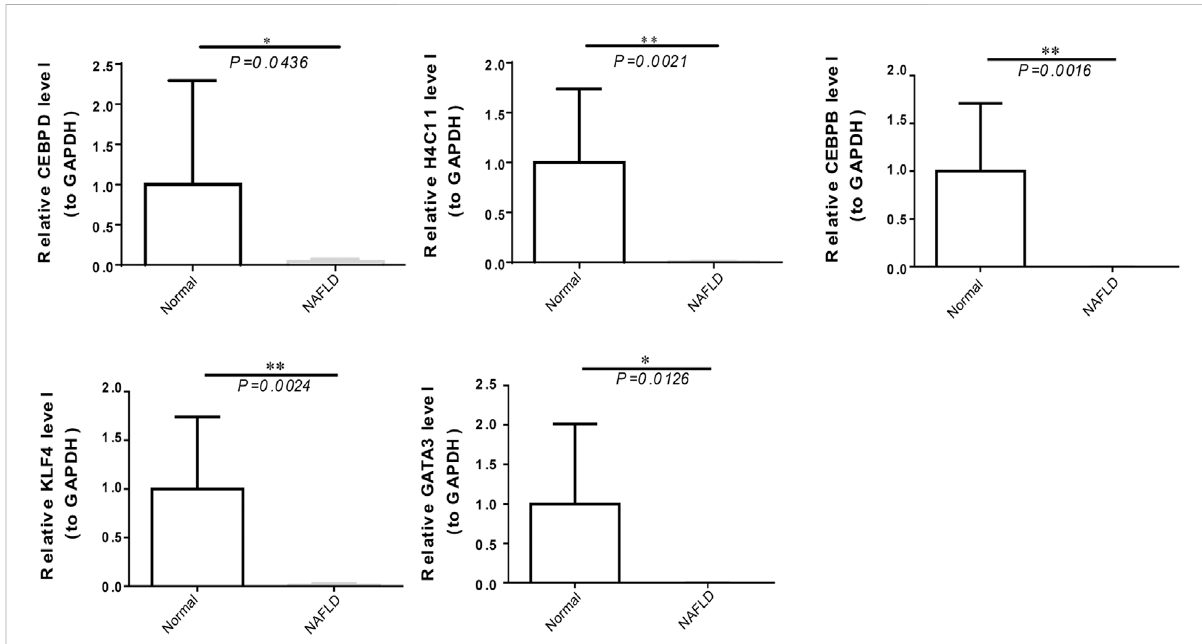
FIGURE 7 The expression of diagnostic biomarkers in the peripheral blood. Veri fi cation of CEBPD, H4C11, CEBPB, GATA3, and KLF4 in peripheral blood mononuclear cells of normal controls and NAFLD patients via qRT ‒